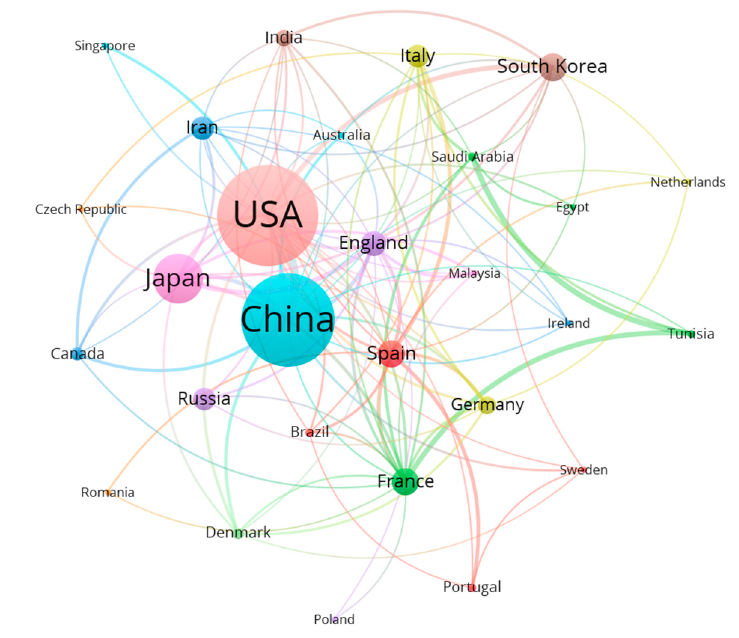
Figure 5. Country cluster map of cooperative published articles from 1998 to 2020.